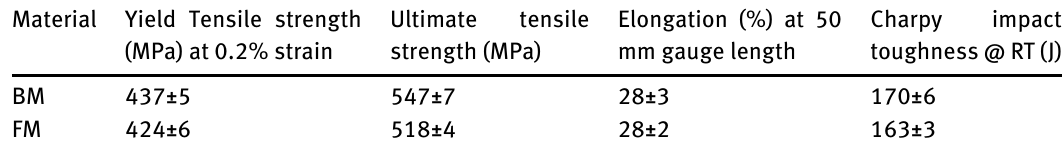
Table 2: Mechanical properties of base metal (BM) and filler metal (FM). Material